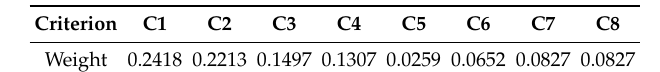
Table 6. Weight of each criterion.